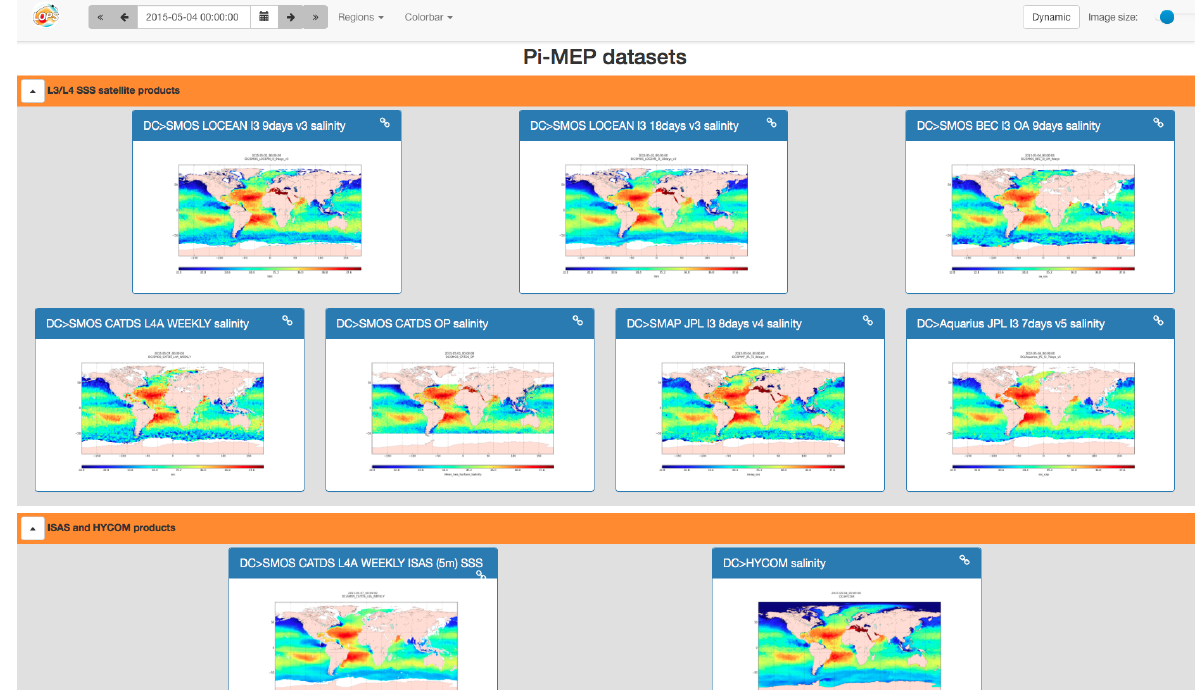
Figure 17. Illustration of the Merginator